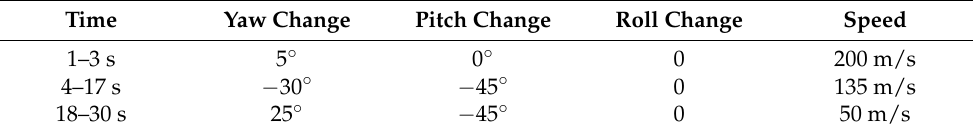
Table 2. The specific value of the attitude and velocity used in the trajectory.